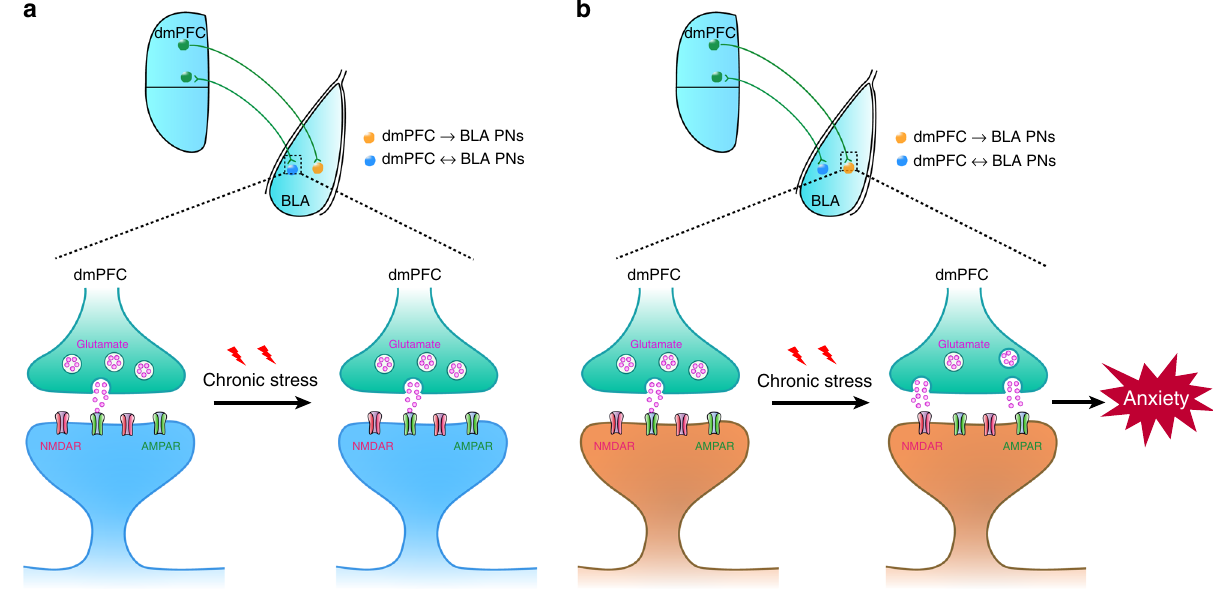
Fig. 8 A working model for target cell-based dysregulation of dmPFC-to-BLA transmission associated with chronic stress-induced anxiety. a Chronic stress does not affect prefrontal glutamate release onto BLA PNs that are reciprocally connected with dmPFC (dmPFC ↔ BLA PNs). b Chronic stress augments prefrontal glutamate release onto BLA PNs receiving mono-directional dmPFC inputs (dmPFC → BLA PNs), contributing to stress-induced increase of anxiety-like behavior in